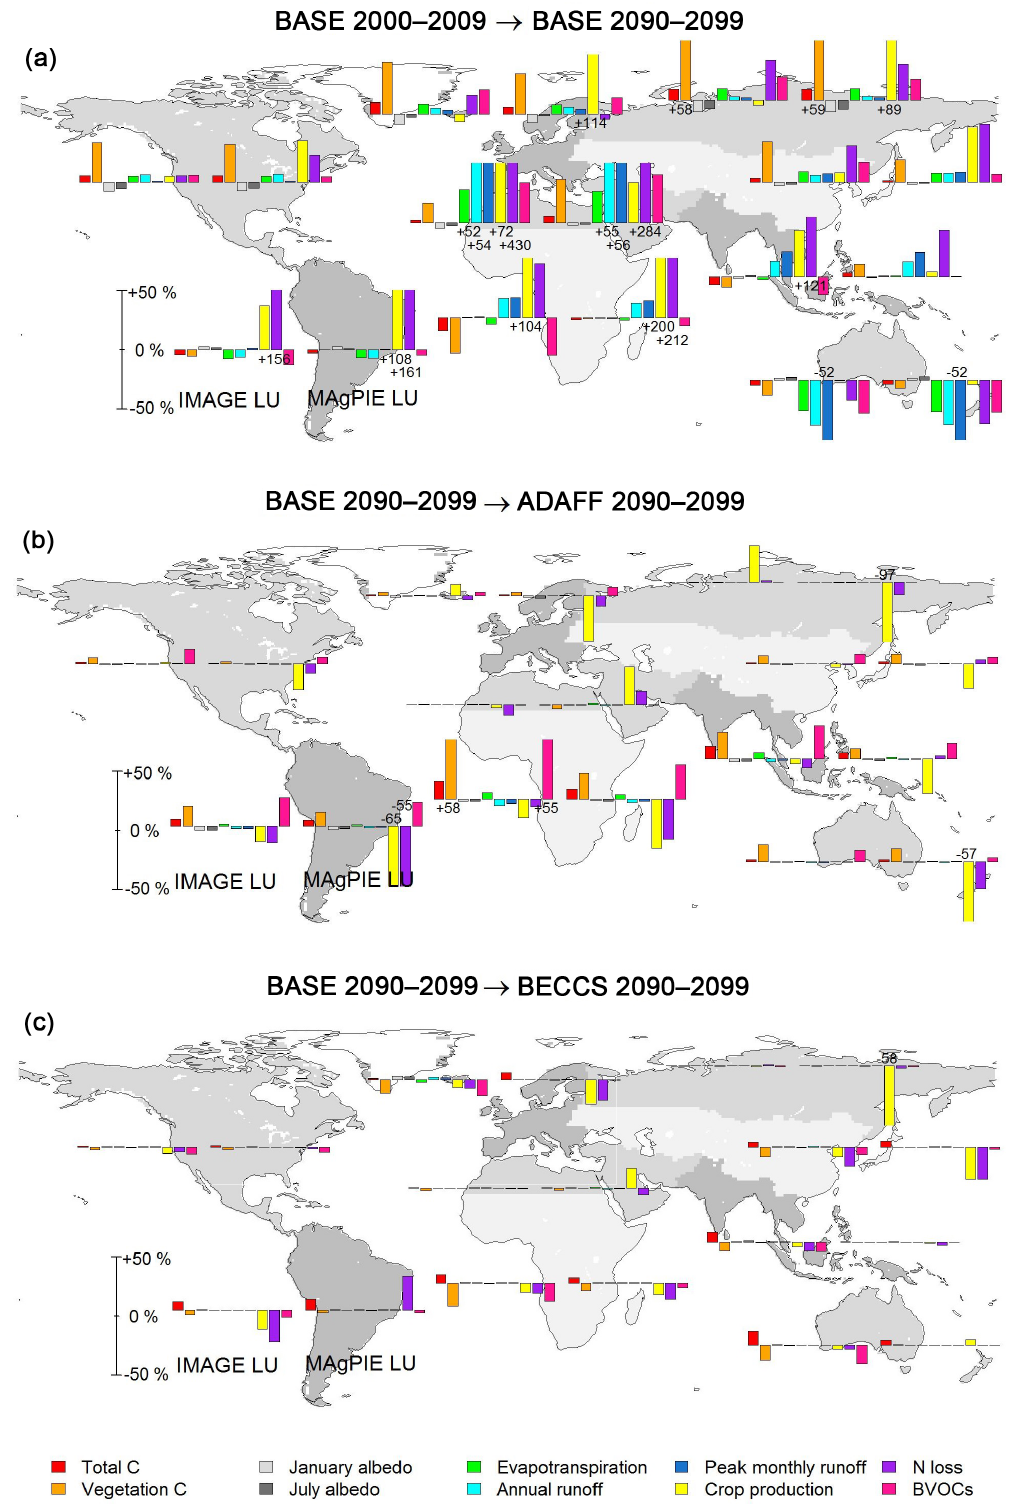
Figure 4. Regional relative changes in analysed ecosystem functions as simulated by LPJ-GUESS for IMAGE-LU (left) and MAgPIE-LU (right). Changes are capped at ± 50% for clarity reasons, values exceeding ± 50% are written upon or below the bar. Regions are aggregated Global Fire Emissions Database regions (Giglio et al., 2010) and are North America, South America, Europe, Middle East, Africa, North Asia, Central Asia, South Asia, and Oceania. (a) Changes in the BASE simulation from 2000–2009 to 2090–2099. (b) Changes from BASE to ADAFF by the 2090–2099 period. (c) Same as panel (b) but from BASE to